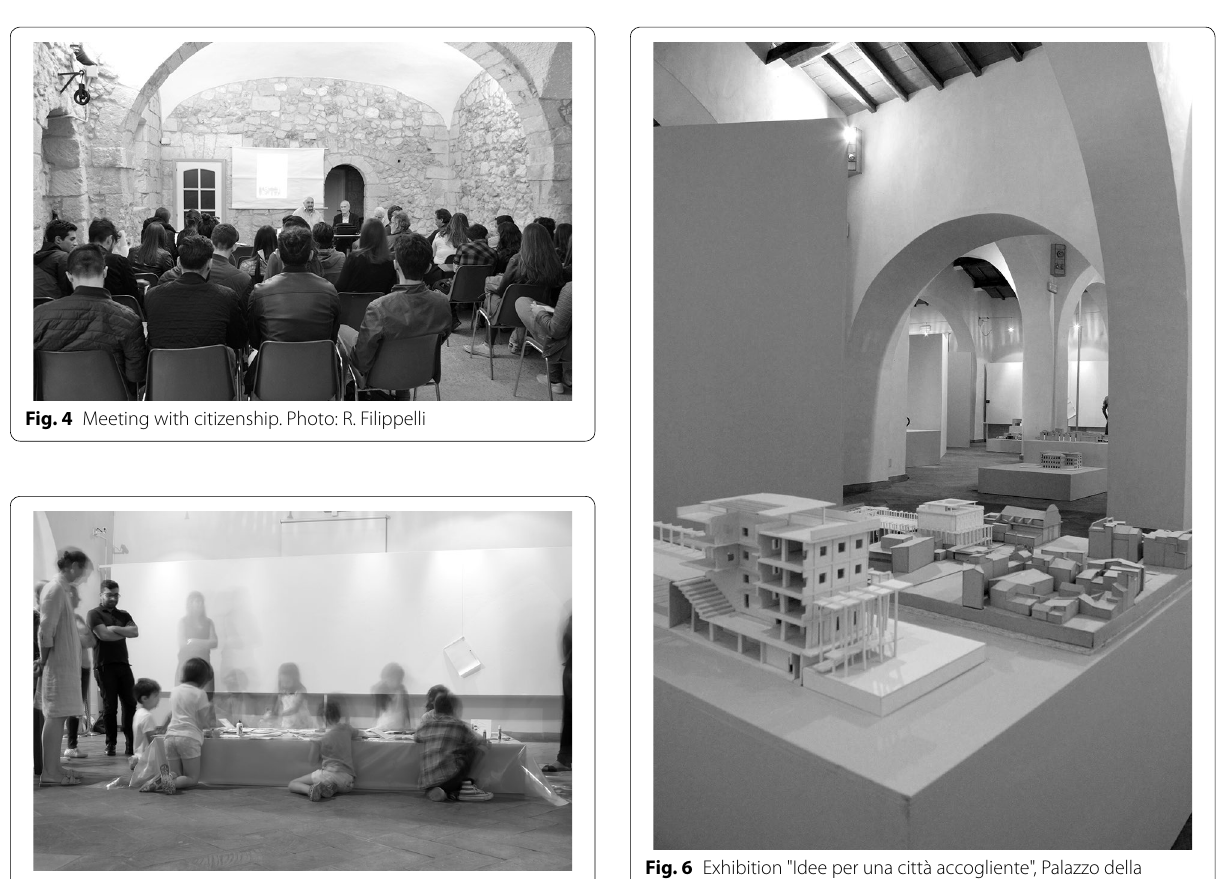
Fig. 5 Laboratory game by the research laboratory LEAP (S. Bartocci, G.M. Biddau, L. Lutzoni, M. Valentino). Palazzo della Frumentaria, Sassari, 2016. Photo: G.M. Biddau